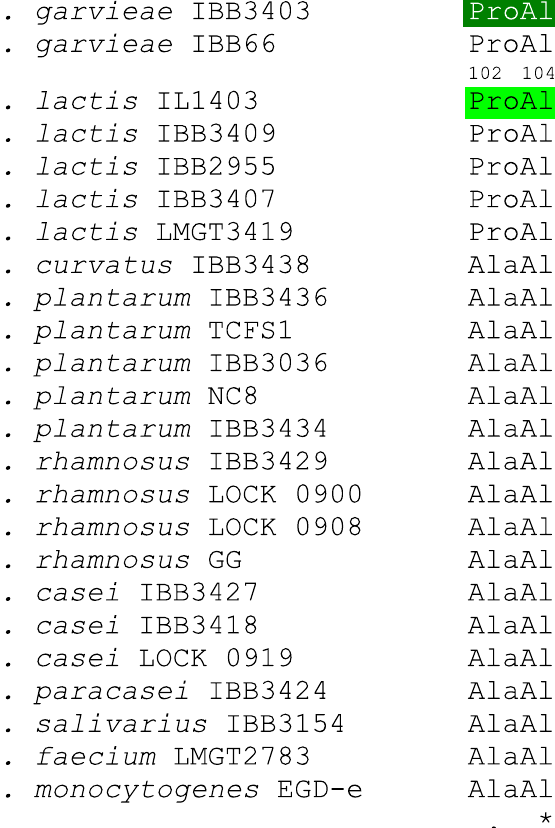
6 Scientific RepoRts | 7: 8359 | DOI:10.1038/s41598-017-09102-7